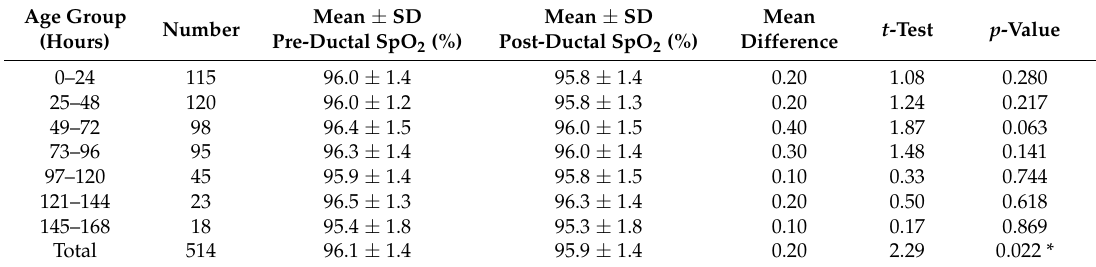
Table 4. Comparison of pre- and post-ductal saturation by pulse oximetry (SpO 2 ) of the study subjects.